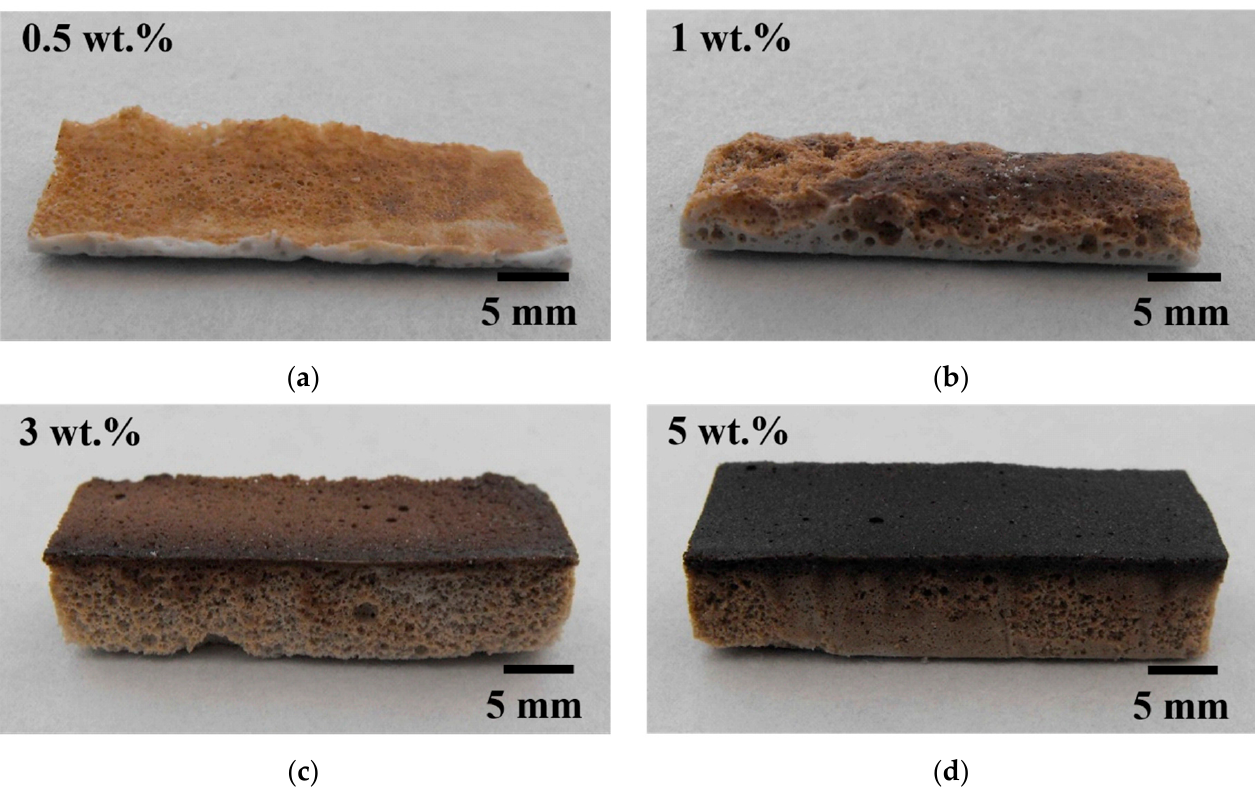
Figure 5. Effect of the content of SE on the macro characteristics of the MgAl 2 O 4 foams. ( a ) 0.5 wt.%; ( b ) 1 wt.%; ( c ) 3 wt.%; and ( d ) 5 wt.%.